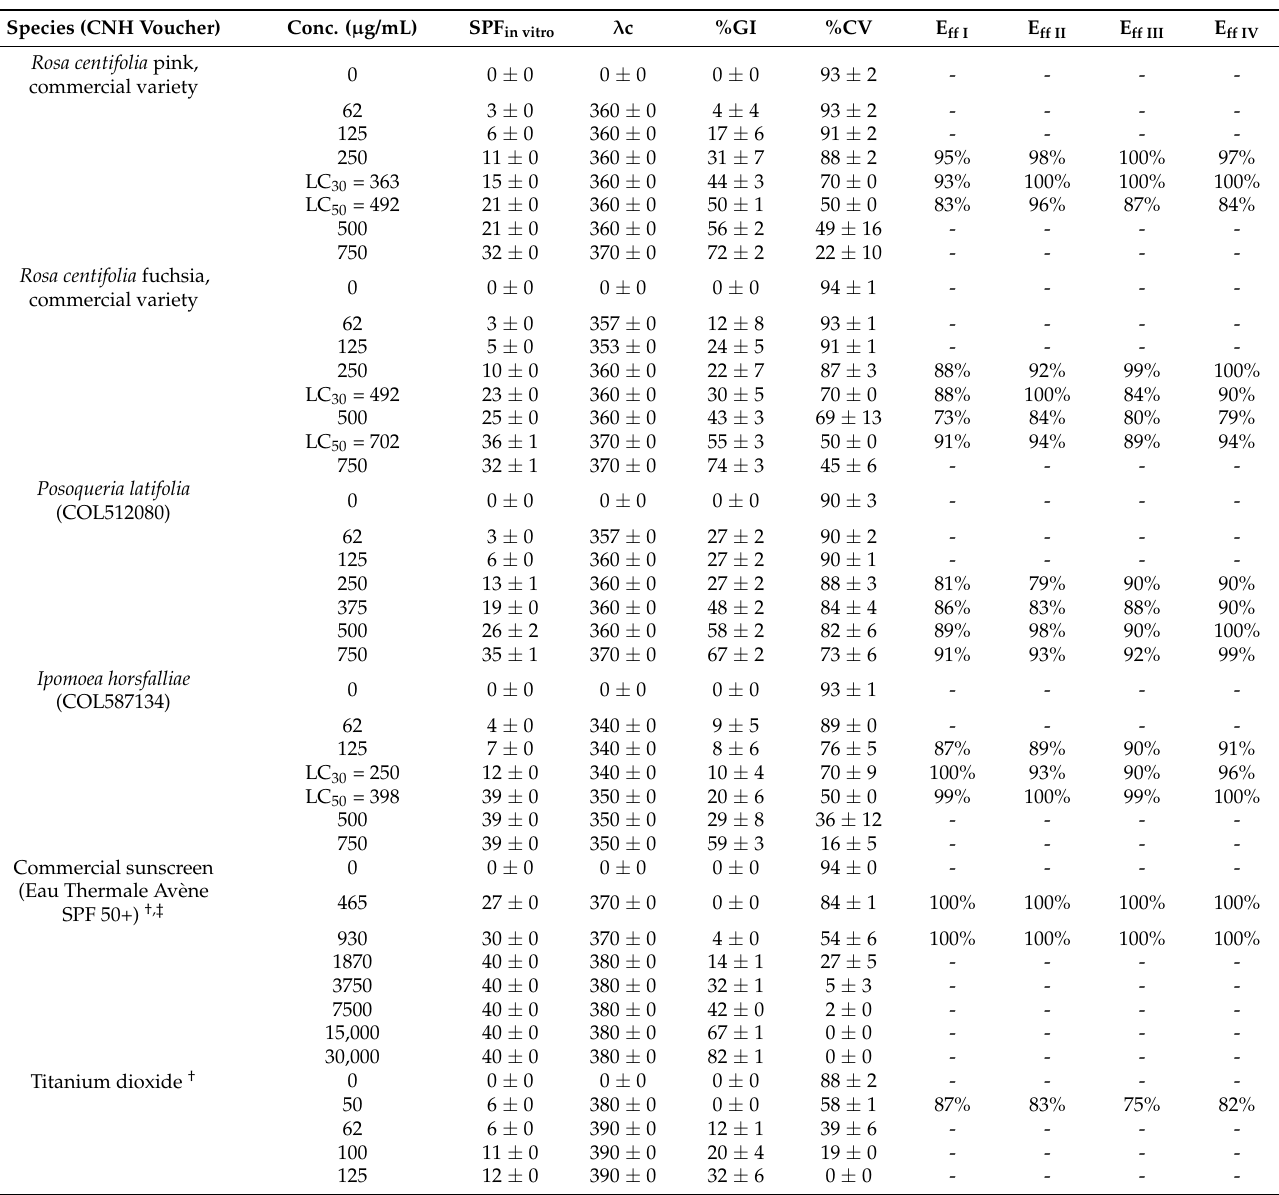
The SPF in vitro values calculated for each flower extract are presented in Table 1. Ac- cording to the European Commission categories (see Section 4), the four flower extracts showed UVB photoprotection efficacy (SPF in vitro ≥ 6.0); the SPF in vitro values increased with concentration (R = 0.97, p < 0.001, Figure 2A). Except for the I. horsfalliae extract, other extracts also showed broad-spectrum (UVA-UVB) protection efficacy ( λ c ≥ 370 nm) at a high extract concentration (750 µ g/mL). Table 1. List of the studied plant species. For each plant extract, the following indices are shown: (i) UVB protection efficacy (SPF in vitro ); (ii) critical wavelength ( λ c); (iii) genotoxicity inhibition percentage (%GI) obtained using the SOS Chromotest; and (iv) percentages of human fibroblast cell viability (%CV). At photoprotective and non-cytotoxic extract concentrations, the percentage of effectiveness (E ff ) values was also estimated for the minimum erythema dose (MDE) according to the Fitzpatrick skin